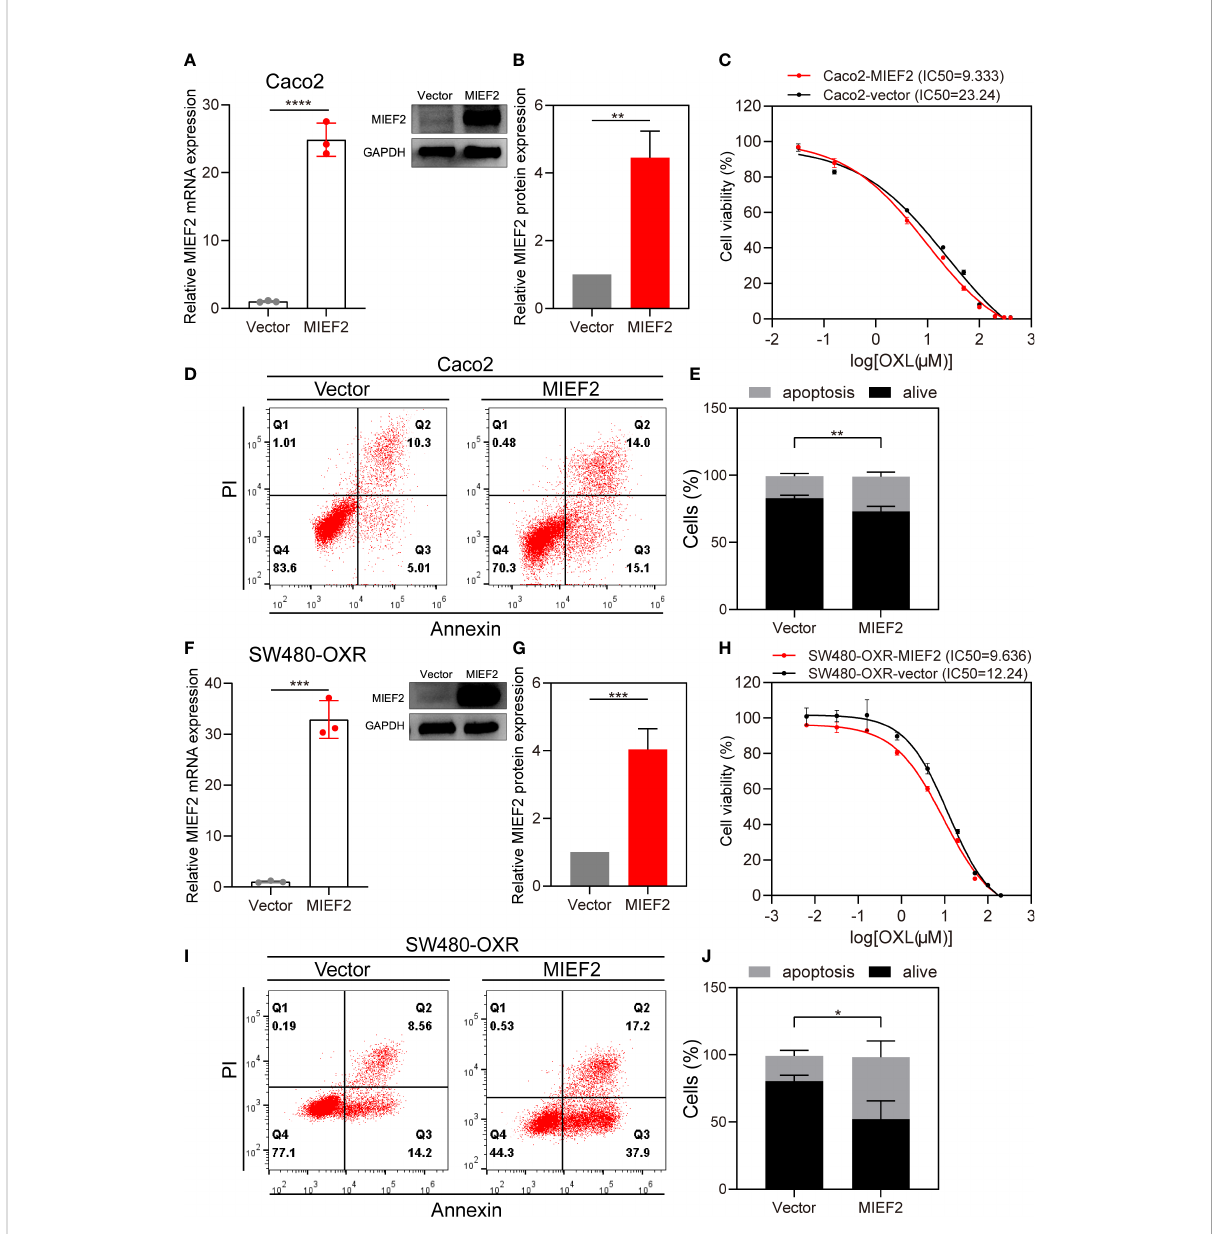
FIGURE 5 Overexpression of MIEF2 partially restores CRC sensitivity to OXL. (A, B) qPCR and western blotting to show overexpression of MIEF2 in Caco2. Bar plots show MIEF2 expression of vector and MIEF2 expressing clones. Statistical analysis was performed using two-tailed unpaired t-test. ** P <0.01, **** P <0.0001 (mean ± SD, n=3 repetitions). (C) OXL Dose-response curves of vector and MIEF2 expressing clones in Caco2 (black connected dots: Caco2-vector, red connected dots: Caco2-MIEF2). (D, E) Comparison of apoptosis induction between vector- and MIEF2- transfected Caco2 cells after oxaliplatin treatment by fl ow cytometry analysis. Overexpression of MIEF2 upregulates cell apoptosis after OXL treatment in Caco2. Stacked plots show the percentage of apoptotic (AnnexinV+) and viable (AnnexinV − /PI − ) cells. Statistical analysis was performed using two-tailed unpaired t-test. ** P <0.01 (mean ± SD, n = 3). (F – J) The same results as Caco2 were detected after overexpression of MIEF2 in SW480-OXR. Statistical analysis was performed using two-tailed unpaired t-test. * P <0.05, *** P <0.001 (mean ± SD, n =